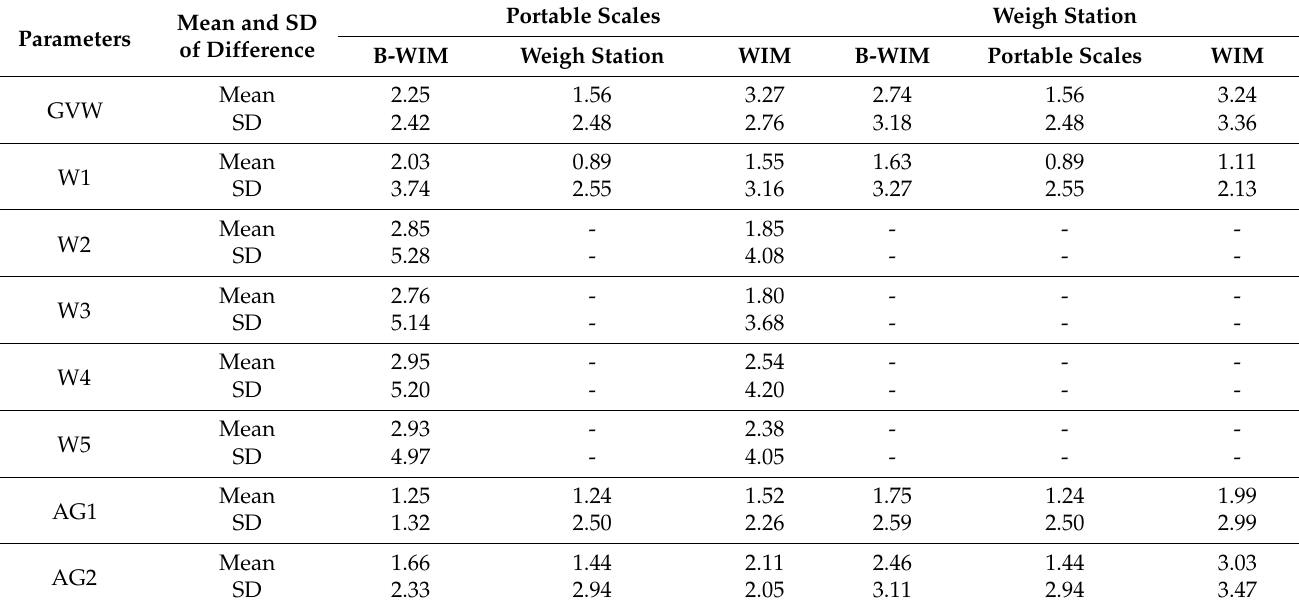
Table 8. Mean and standard deviation of difference for vehicle attributes compared to portable scales and weigh station